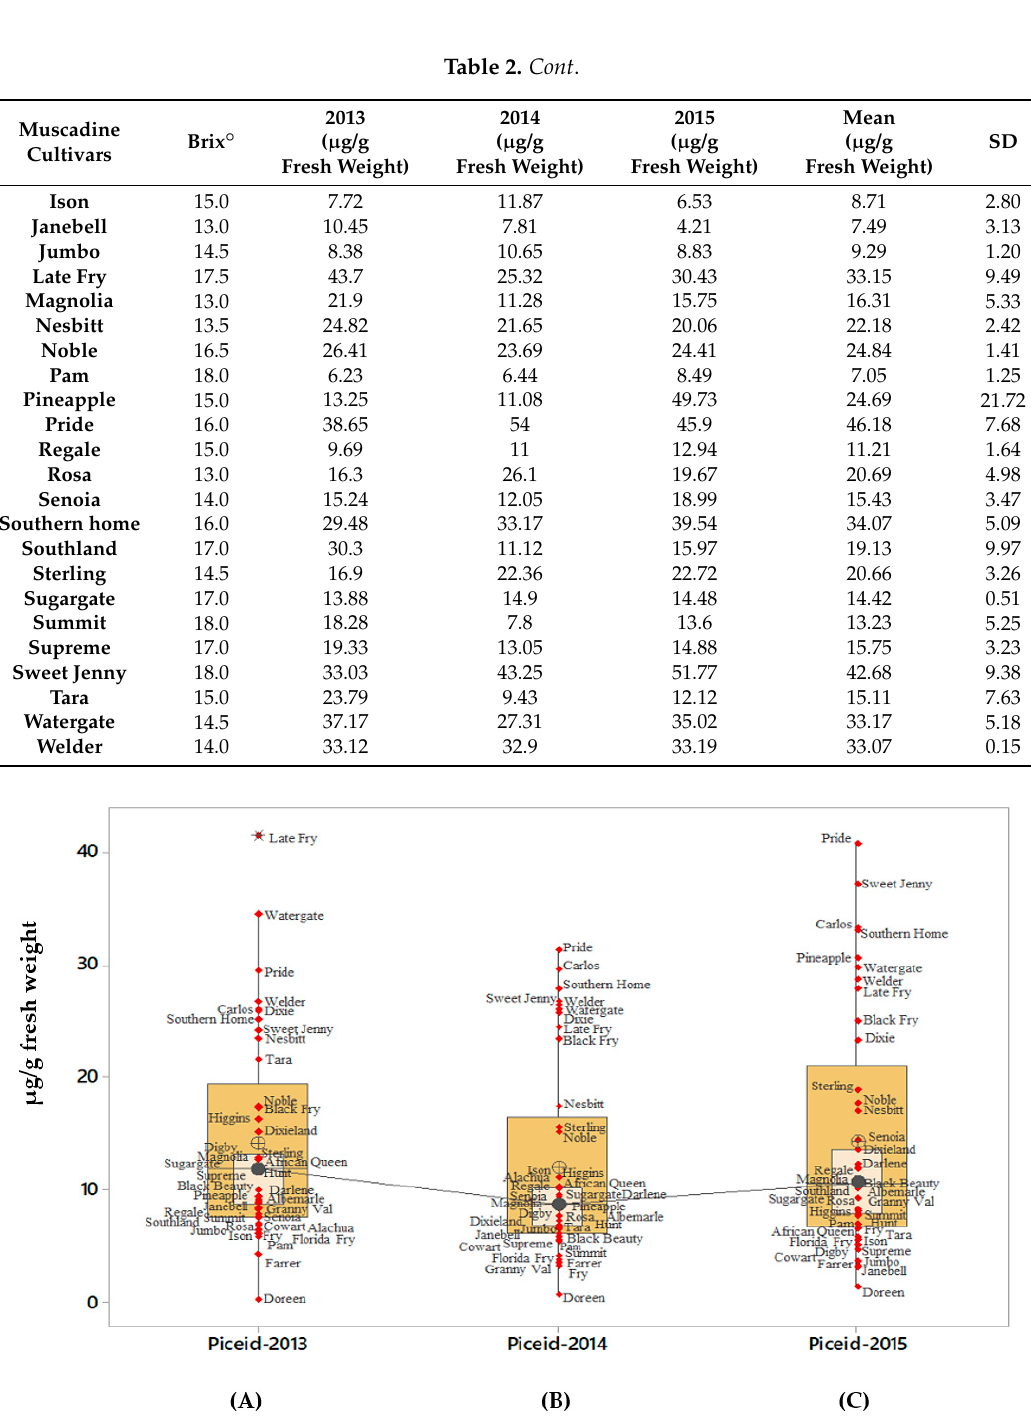
Figure 2. Variation of t -piceid content in different muscadine cultivars. The total t -piceid content was estimated for 41muscadine cultivars. The values presented in the boxplot format represents the data of 50% of the cultivars in the interquartile range, while the inside box represented 95% confidence interval for the median. The line connecting individual boxplot is the median line for the t-piceid content recorded for the three consecutive years 2013, 2014 and 2015. Each symbol represents the individual muscadine cultivar, the maximal, and the minimal values excluding outliers. Asterisks indicate the outliers. Symbols A , B , and C represent the average of total t-piceid obtained for the years 2013, 2014, and 2015 respectively by summing up the total t-piceid content for each variety obtained from three technical and biological replicates. Data obtained from cv. Fry Seedless have not been included in the figure.